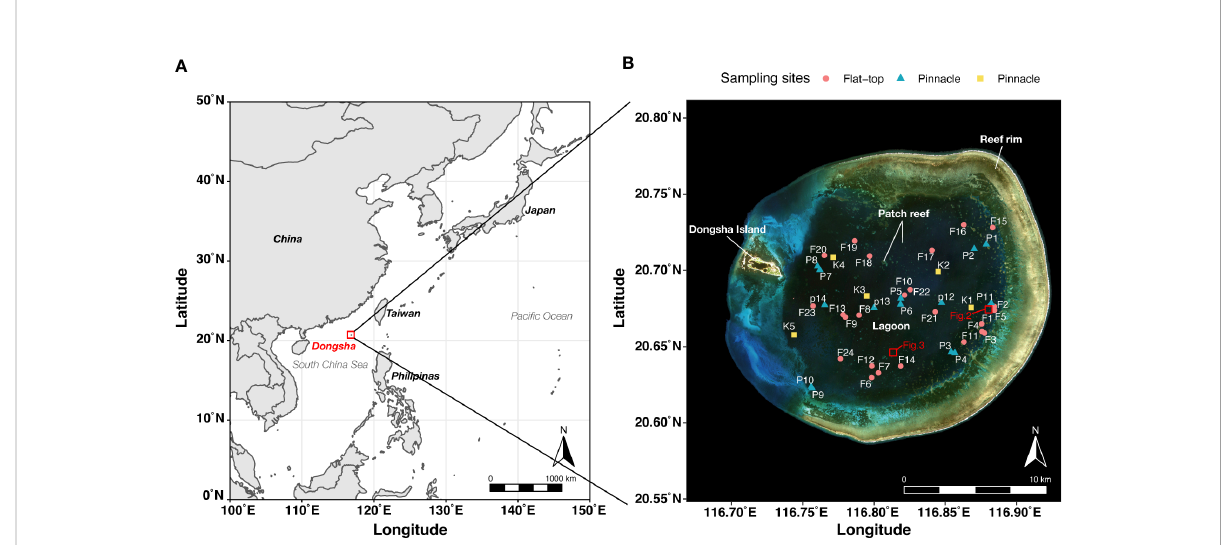
FIGURE 1 Dongsha Atoll sampling sites. (A) Dongsha Atoll (red square) is located in the northern South China Sea at 20.70°N and 116.80°E. (B) Coral core samples were collected from the surfaces of 24 fl at-top patch reefs (red circles, F1 – F24) and 14 pinnacle-top patch reefs (blue triangles, P1 – P14) in the Dongsha Atoll lagoon. Coral cover data of fi ve pinnacle-top patch reefs were obtained using transect photographs (photographs along 25 m line transect; yellow squares, K1 –